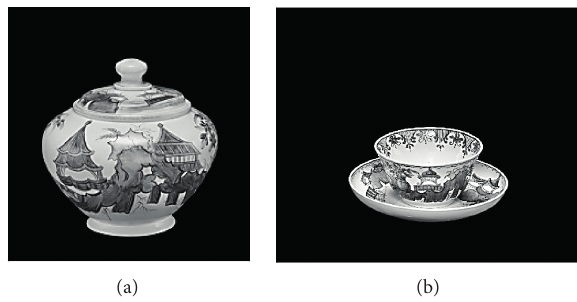
Figure 9: Multicast is the sending of data packets to a host group represented by a unique IP address.